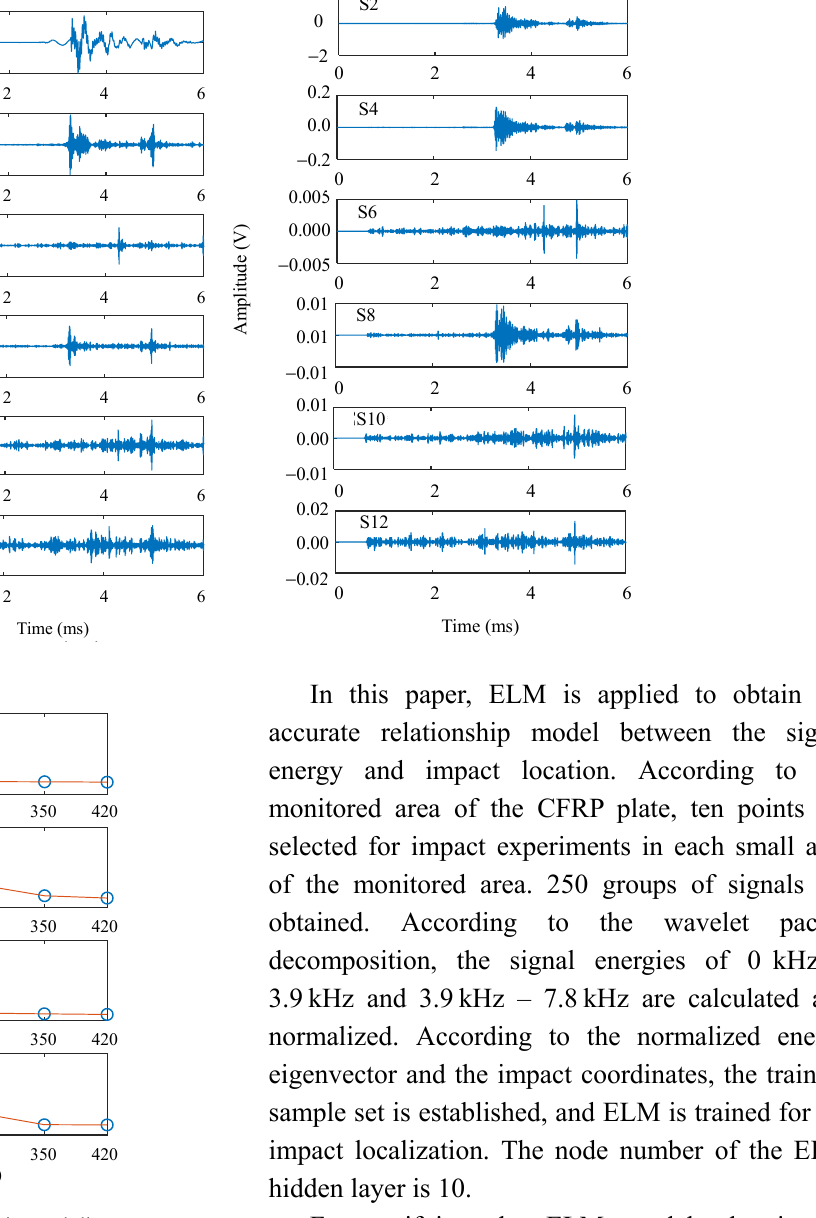
Fig. 7 Relationship between the energies and